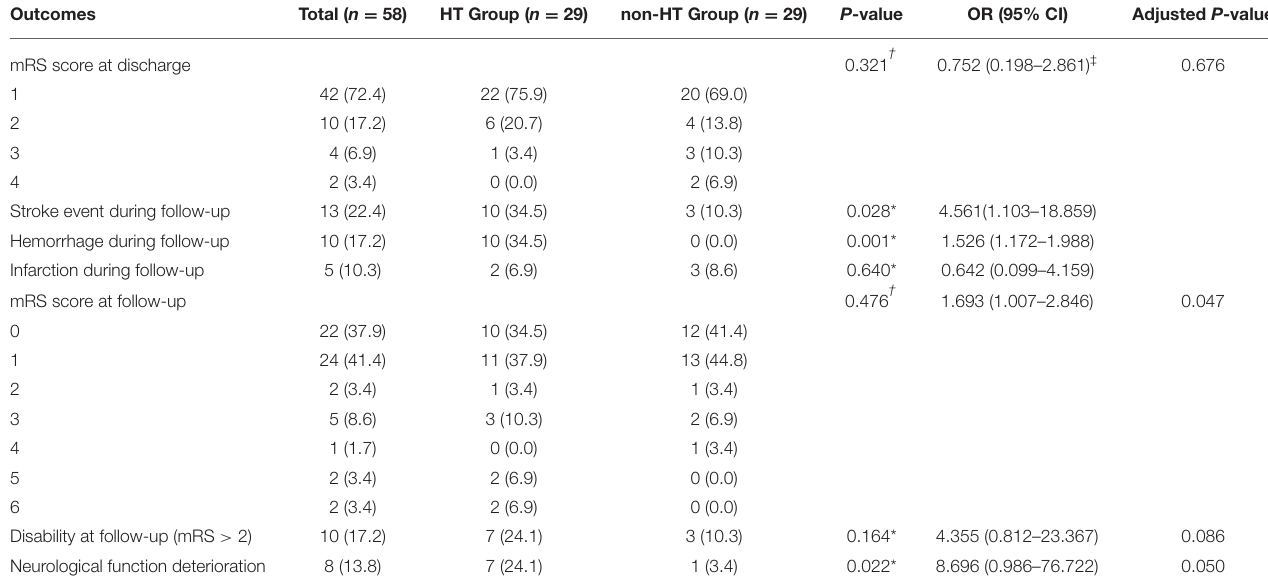
TABLE 4 | Outcomes of patients in the propensity score–matched cases.